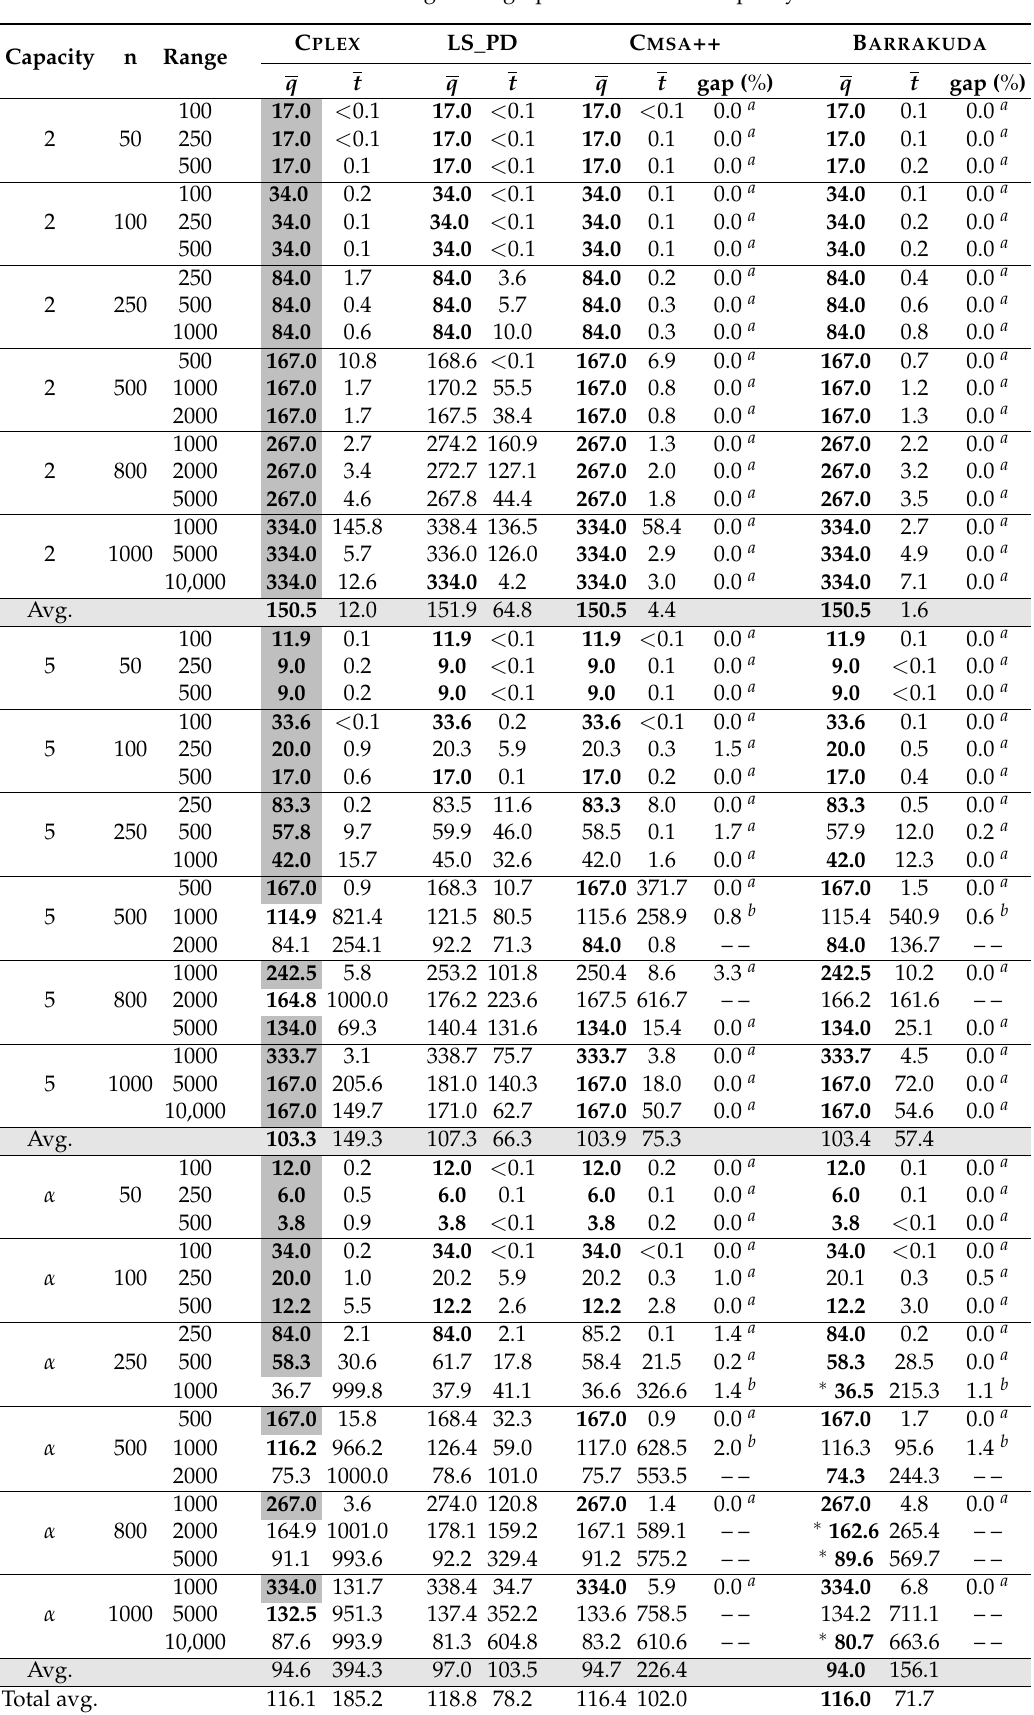
Table 5. Results for general graphs with uniform